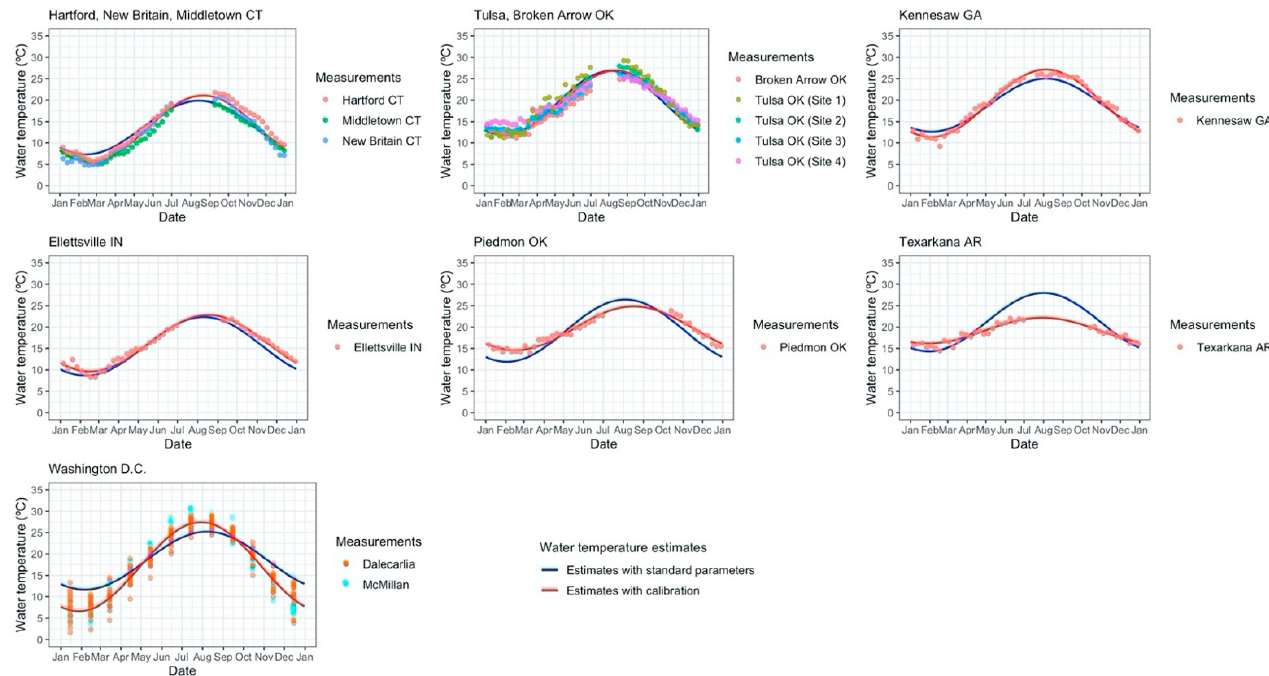
Figure 2. Comparisons between water temperature measurements and the water temperature estimates from the NREL model. The water temperature measurements (with the exception of Washington D.C.) were obtained from Abrams and Shedd [24] and were recorded in the water supply piping of 12 residential sites during the period 1994–1995. For the further calibration of the NREL model, the root mean square errors (RMSEs) were calculated between the measurements and the corresponding weekly or monthly averages of water temperature estimates. Station information for the air temperature records used for the seven locations can be found in Supplemental Materials Section B.